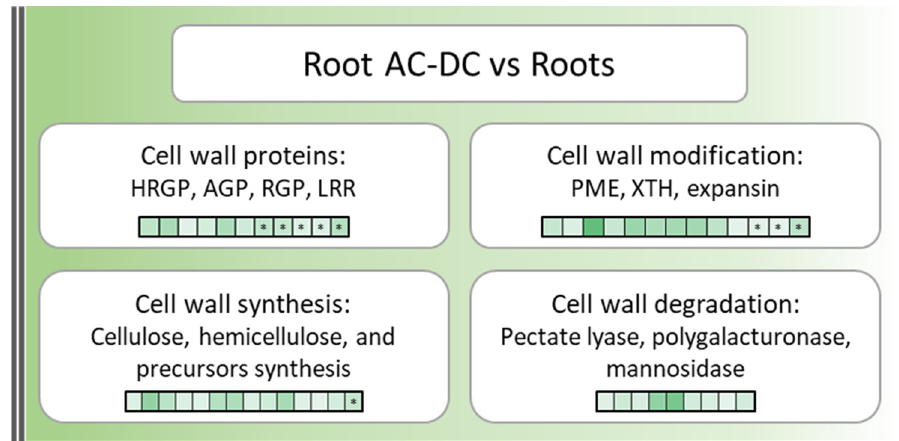
Figure 2. Cell wall over-expressed genes and proteins in root AC-DC compared to roots in consti- tutive conditions. Each square corresponds to a gene or protein (squares with *), dark green squares correspond to highly overexpressed genes or proteins compared to roots, light green squares corre- spond to lowly overexpressed genes or proteins in root AC-DC compared to roots (fold change ≤ 0.66 or fold change ≥ 1.5; p -value ≤ 0.05).